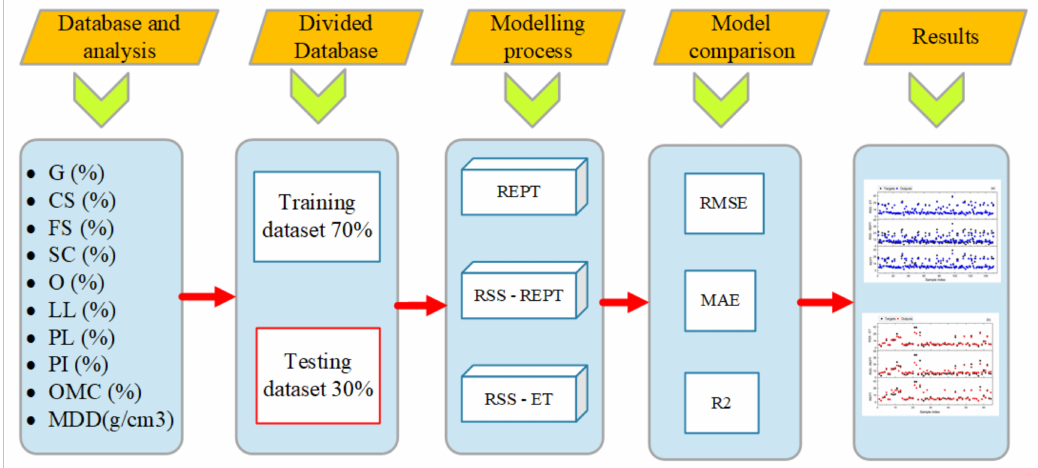
Figure 4. Methodological framework for the predicted values in this